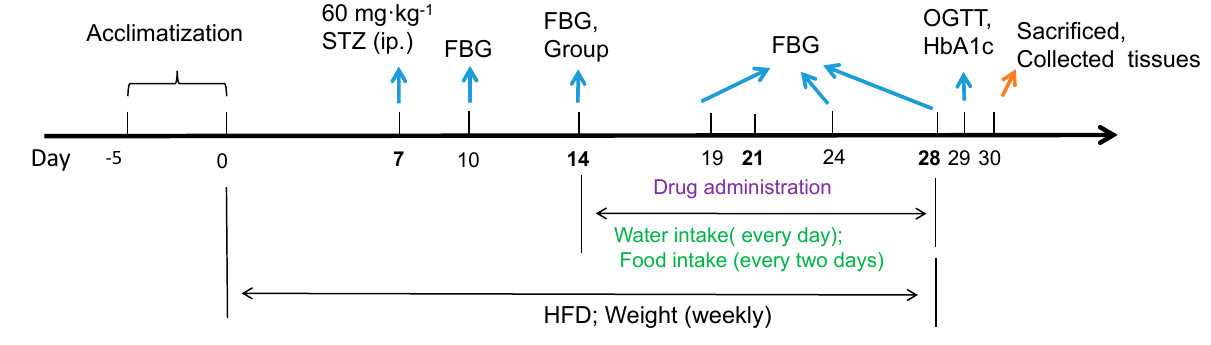
Figure 8. The experimental procedure. After 5 days of acclimatization in the Laboratory of Barrier Environment, SD rats were fed a high-fat diet, and one week later (day 7), 60 mg/kg STZ was injected intraperitoneally. The level of FBG was measured on the 3rd (day 10) and 7th (day 14) day after the STZ injection. The rats with the FBG ≧ 13.0 mmol/L were selected and divided into groups. The drug was given for two consecutive 2 weeks. During the administration, the water intake was measured every day, food intake was recorded every two days, and the body was weighed weekly. At the end of the administration, the OGTT was performed and the animals were sacrificed under anesthesia and the tissues were collected. STZ: Streptozotocin; HFD: high-fat diet; FBG: fasting blood glucose; OGTT: oral glucose tolerance test; ip.: intraperitoneal injection.